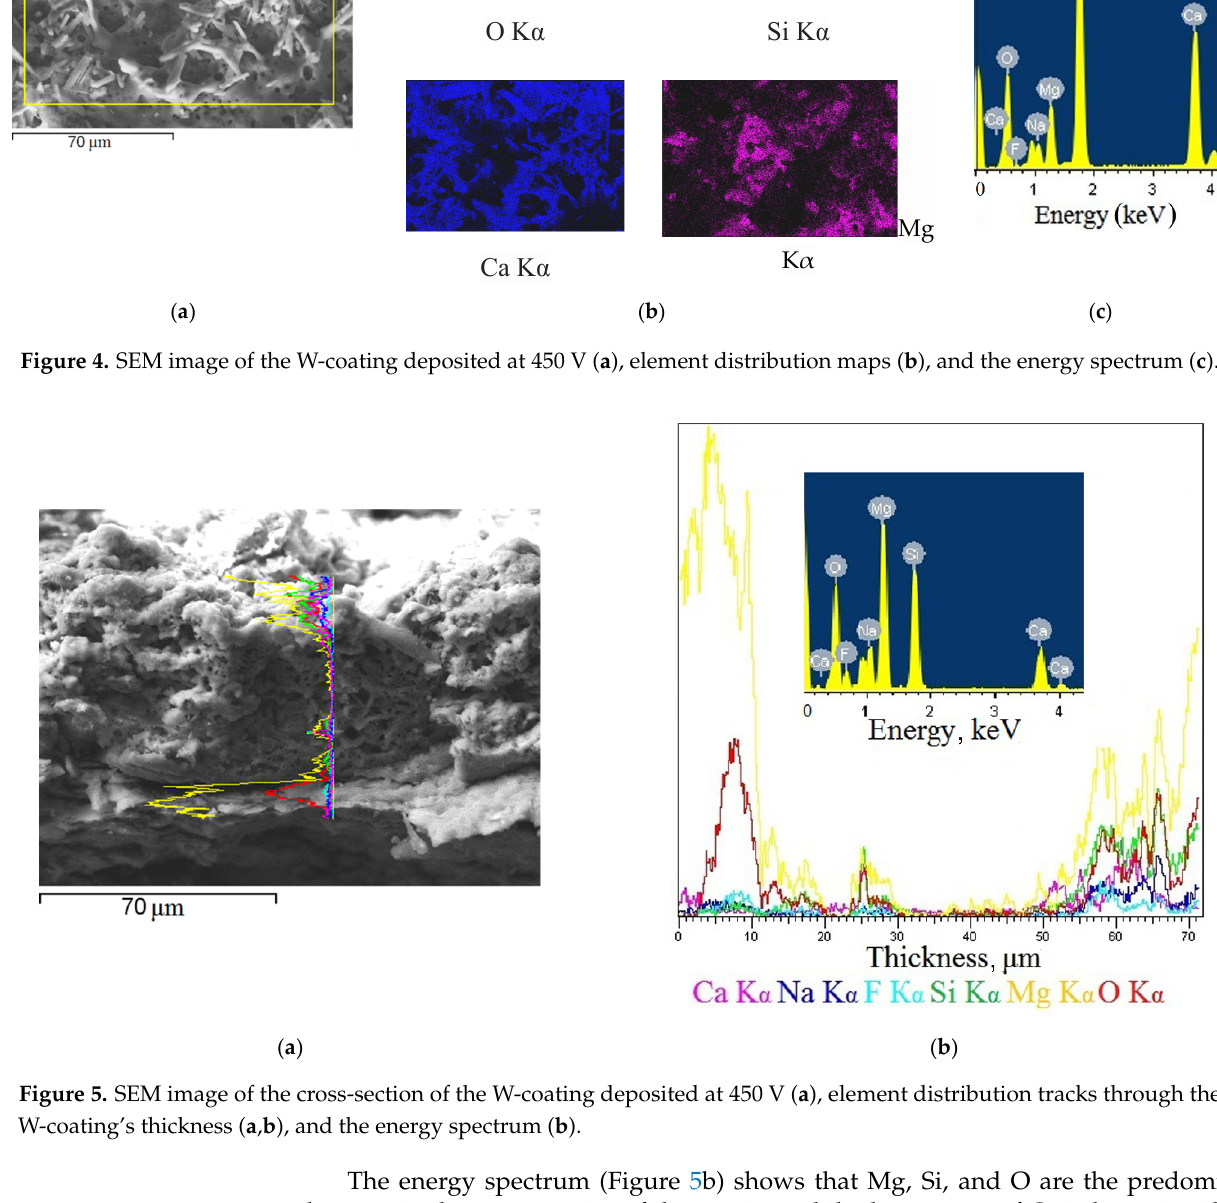
Metals 2021 , 11 , x FOR PEER REVIEW